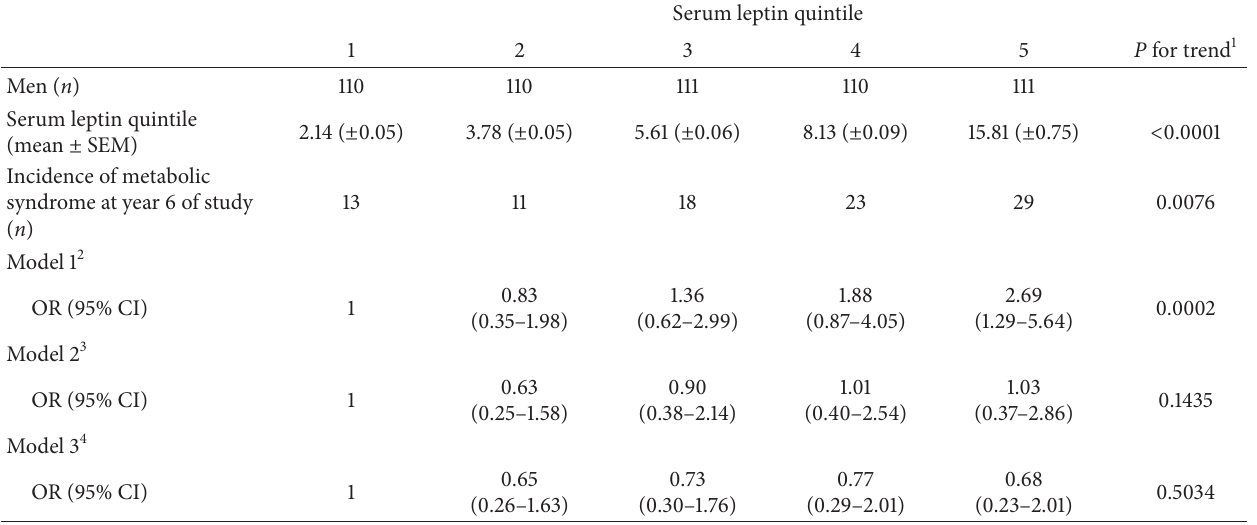
Table 3: Adjusted odd ratios (OR) of the incidence of metabolic syndrome at year 6 by serum leptin quintile among